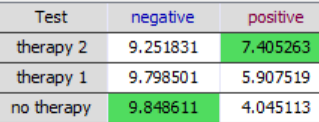
Figure 9. Expected utility for Therapy . When the test is positive, “therapy 2” is chosen because it has the highest expected utility. When the test is negative, the highest expected utility is obtained for “no therapy”.